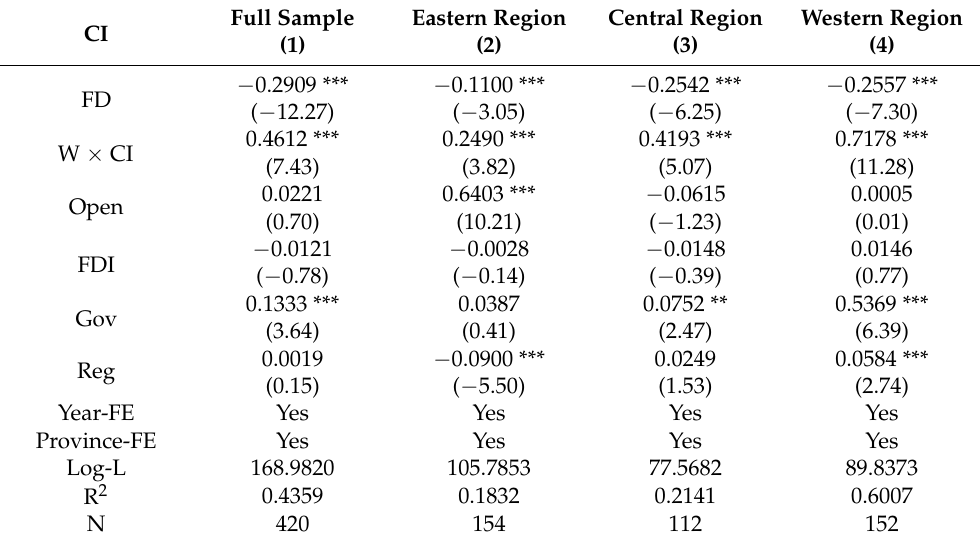
Table 4. Results of the impact of financial development on carbon intensity and the sub-regional heterogeneity